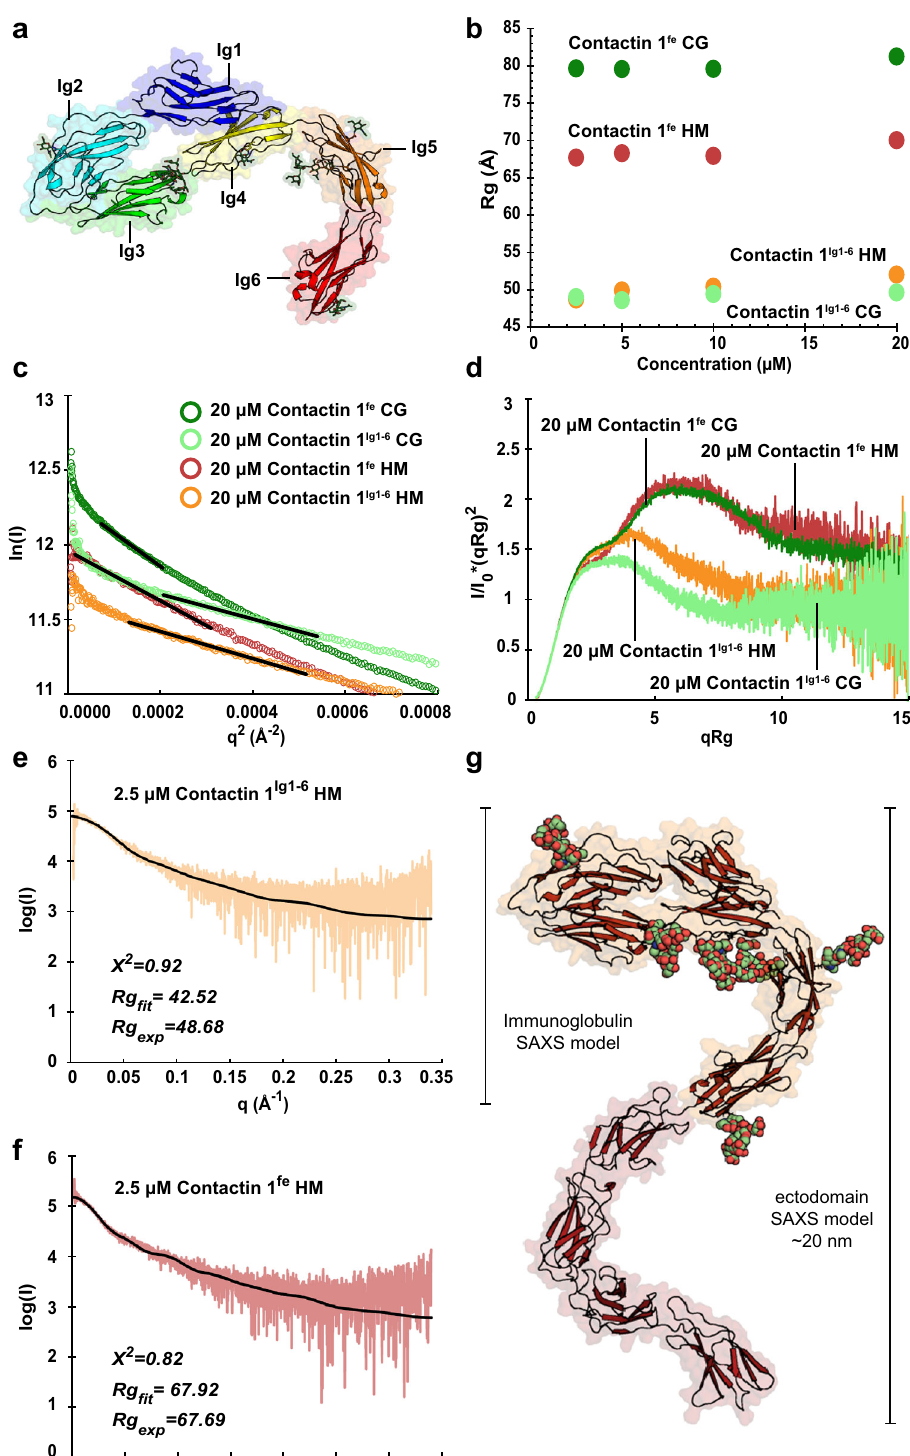
Fig. 3 | Contactin 1 Ig1 – 6 structure has a distinctive sickle architecture and con- tactin 1 fe is more elongated. a Domain rainbow colored contactin 1 Ig1 – 6 monomer. Contactin 1 Ig1 – 6 has a sickle-like shape with the Ig1 – Ig4 horseshoe forming the “ handle ” andtheIg5 – Ig6combinationformingthecurved “ blade ” . b Contactin1 Ig1 – 6 and contactin 1 fe batch SAXS showing stable Rg across measured concentrations. c BatchSAXSguinierplotsshowingcharacteristicupturnatlow q valuesindicating the presence of some oligomers. d Contactin 1 Ig1 – 6 and contactin 1 fe characteristic